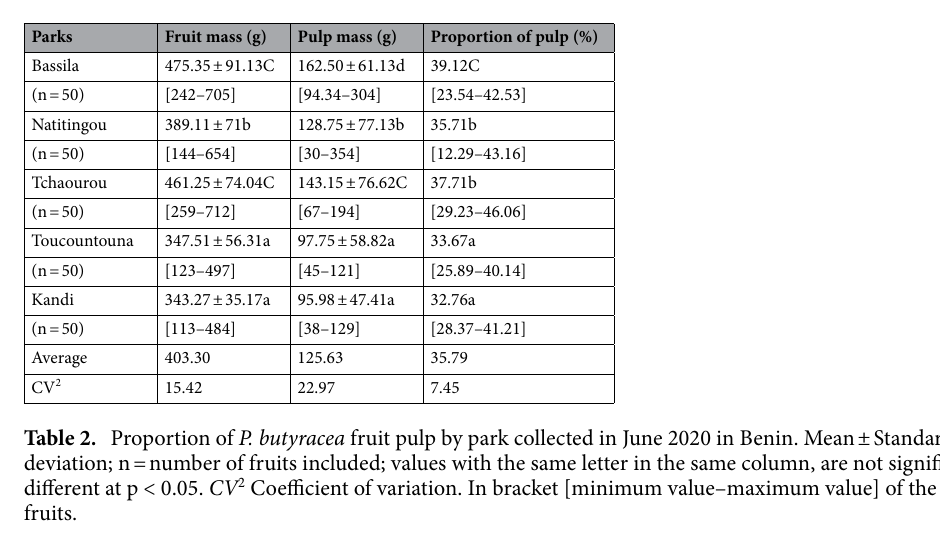
Figure 2. Dimensions of P. butyracea fruits by shape collected in June 2020 in Benin.